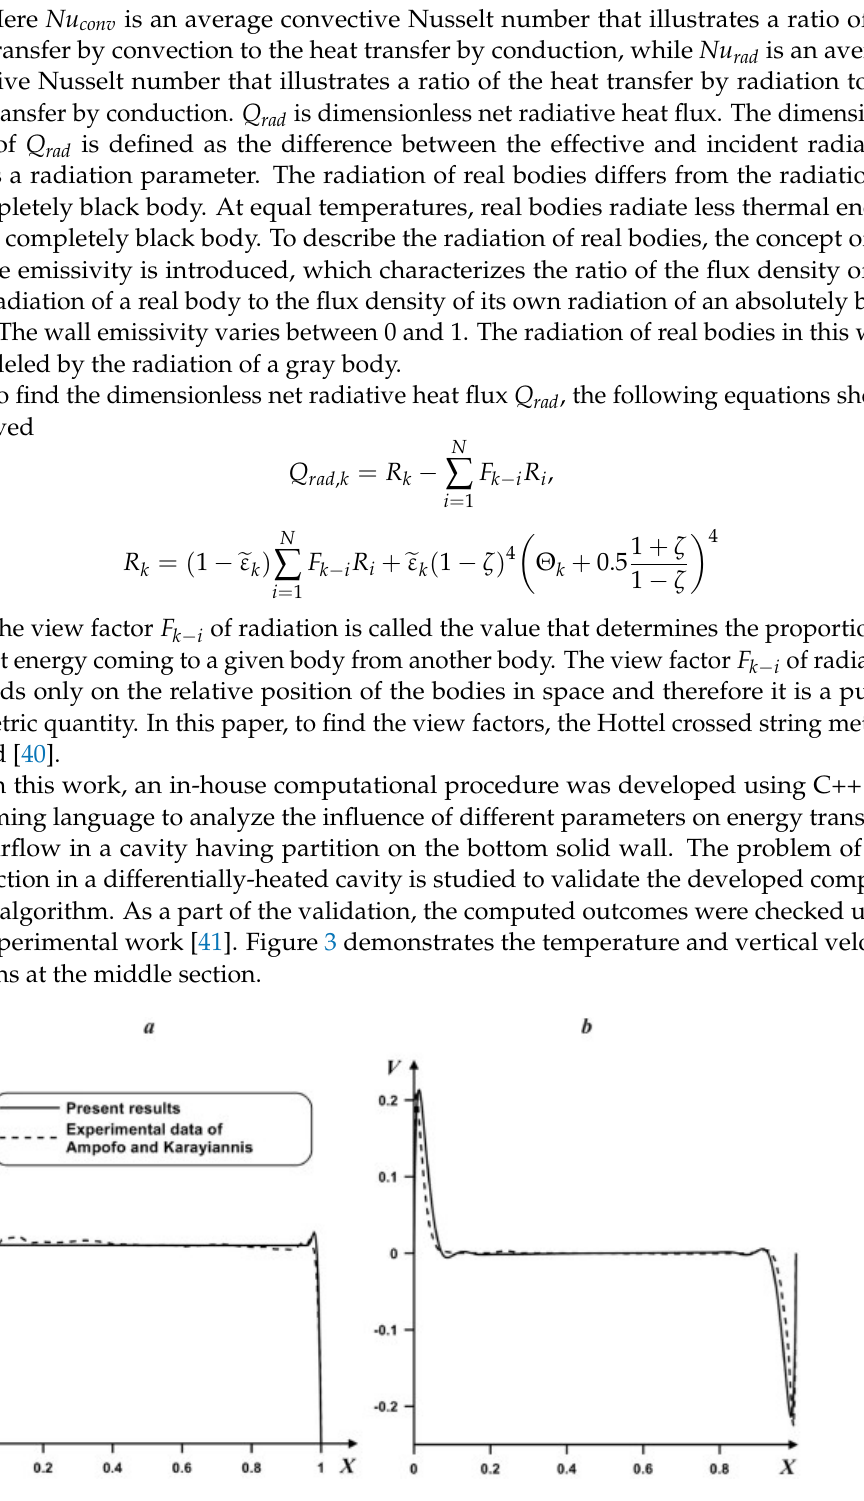
Figure 3. Thermal profiles ( a ) and vertical velocity ( b ) in comparison with outcomes from [41]. In order to make the obtained numerical solutions independent on the mesh, an additional analysis was conducted using three various grids (96 × 96, 120 × 120, 180 × 180) for the case of Ra = 10 9 , Pr = 0.7, λ w,air = 10,000, h/L = 0.2, (cid:101) ε = 0.9. The resulting time series of the average Nu rad at the heated surface are shown in Figure 4. Moreover, the difference of outcomes between the grids of 120 × 120 elements and 180 × 180 elements is less